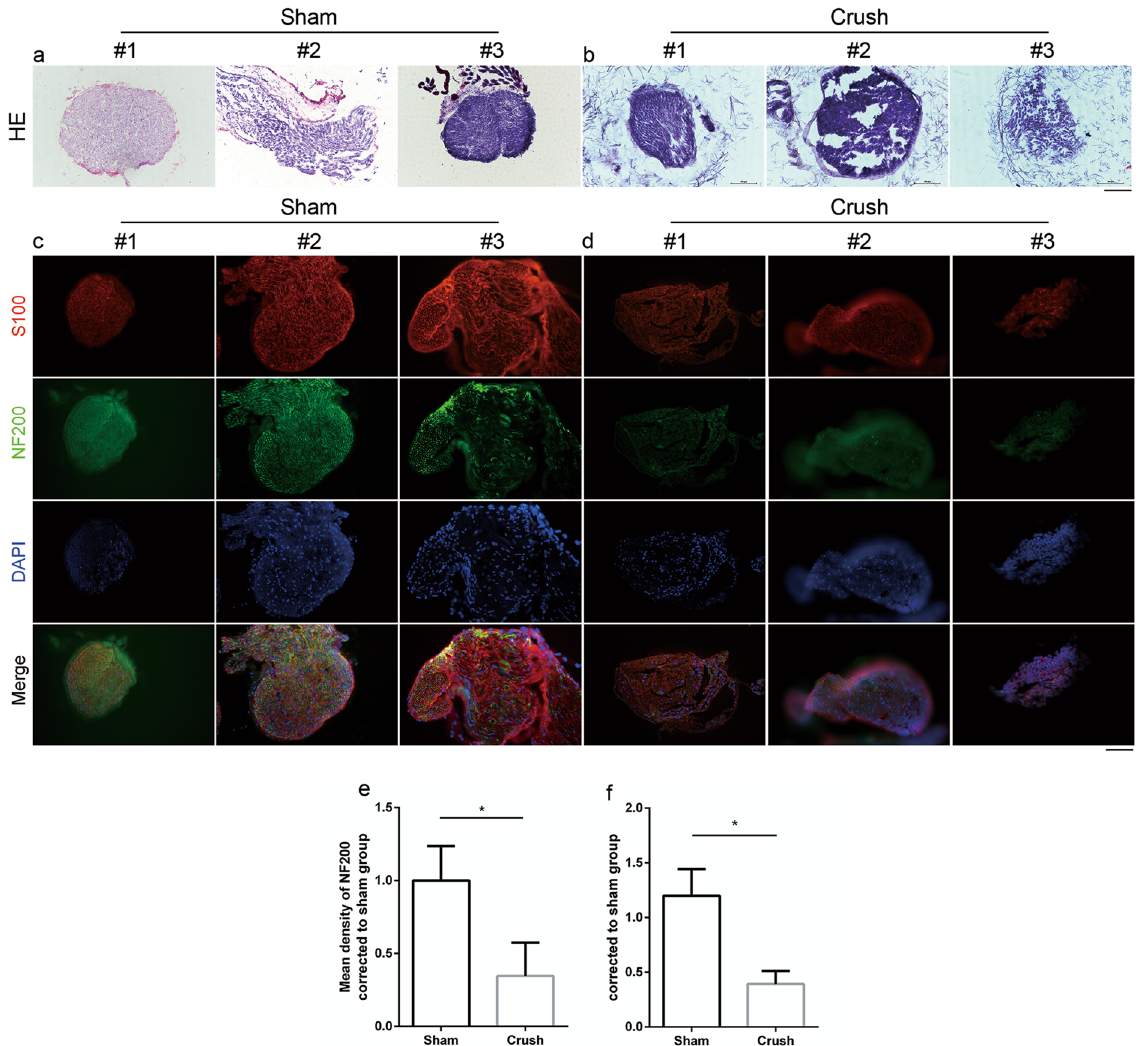
Figure 7. Histological evaluation and immunohistostaining of spinal sacral nerve at 1 w and 4 w. (a#1-a#3 and b#1-b#3) H&E of nerve in two groups. (c#1-c#3 and d#1-d#3) S100 and NF200 immunohistostaining of spinal sacral nerve in sham (20 ×) and crush group (20 ×). ( e and f ) Mean density of NF200 and mean density of S100 in two groups. Data was represented as mean ± SEM. Significance levels were set at * P <